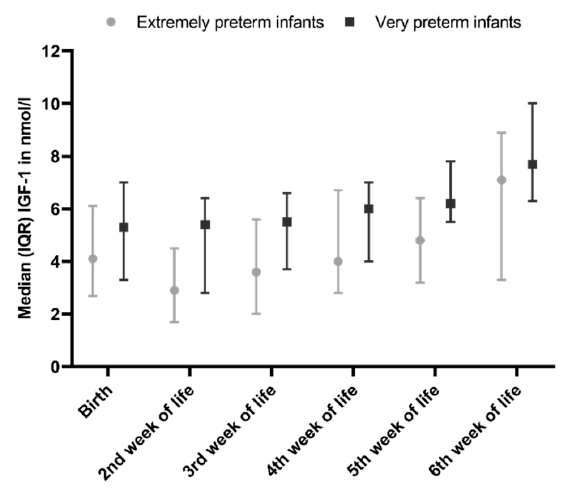
Figure 2. Insulin-like growth factor 1 (IGF-1) levels in extremely preterm and very preterm